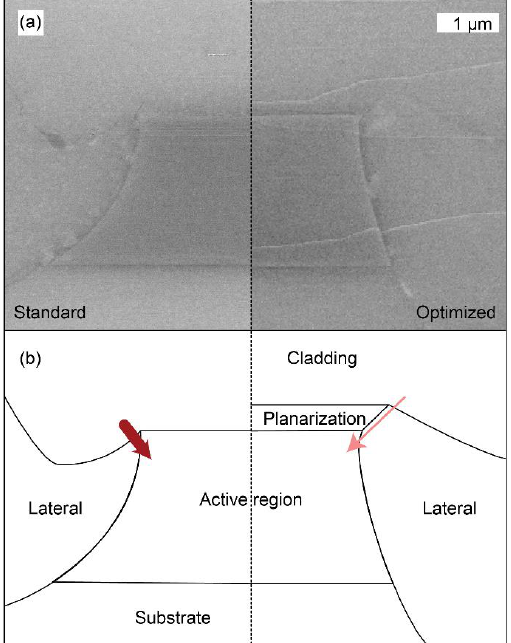
Figure 4. ( a ) Comparison of two SEM micrographs showing the laser facet of two devices, one fabricated with standard procedures, one with optimized procedures; and ( b ) schematic drawing highlighting the most important features depicted in ( a ). The red arrows indicate potential electrical leakage paths. leakage